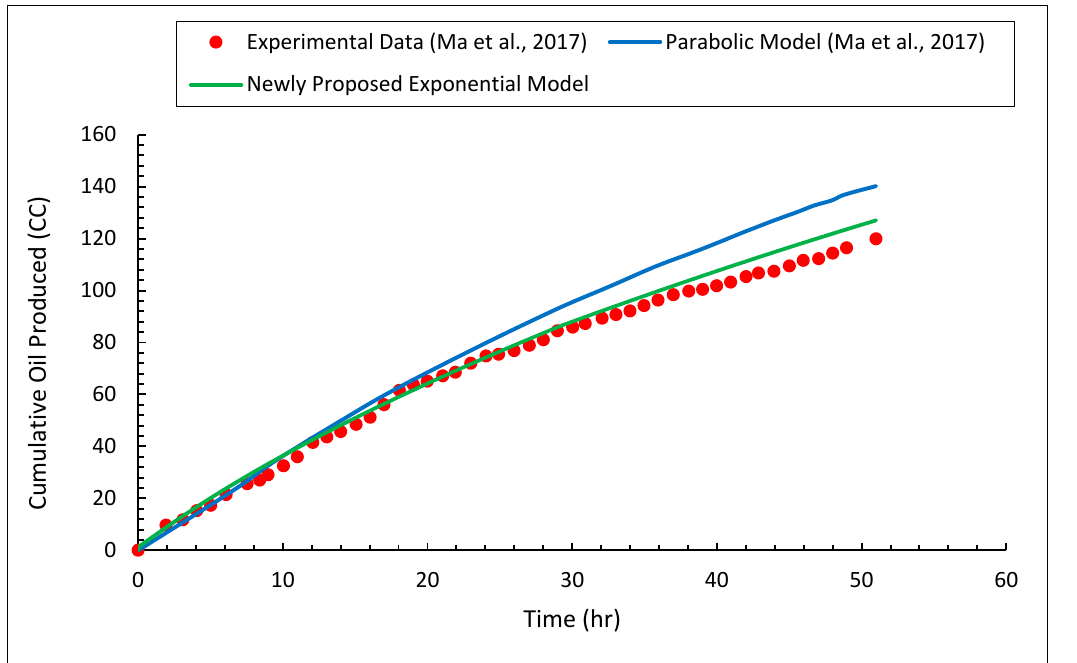
Figure 23. Comparison of the cumulative produced oil estimated by the newly proposed exponential model, experimentally measured cumulative produced oil [3], and cumulative produced oil estimated by the parabolic model proposed by Ma et al. [3] in test #3.